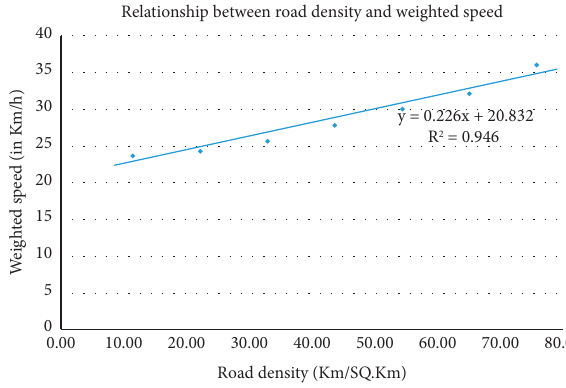
Figure 8: Relationship between road density and weighted speed.